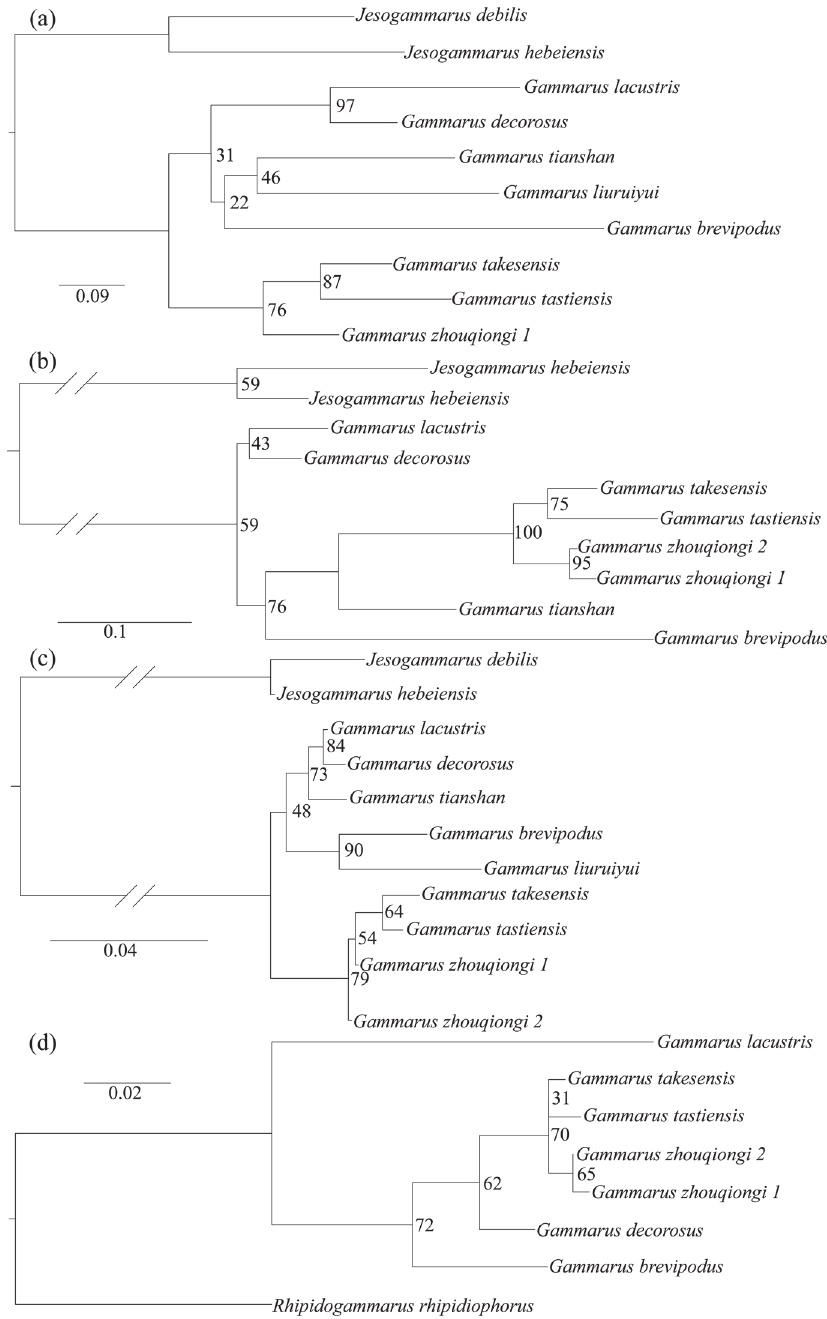
Figure 2. Maximum likelihood trees for Gammarus from Xinjiang based on the four separate